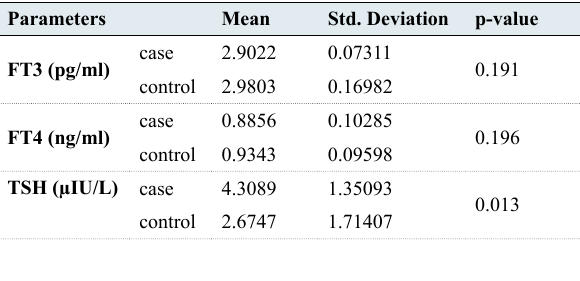
Table 2: Mean and standard deviation of FT3, FT4, TSH in Mild Preeclampsia, and normotensive pregnant